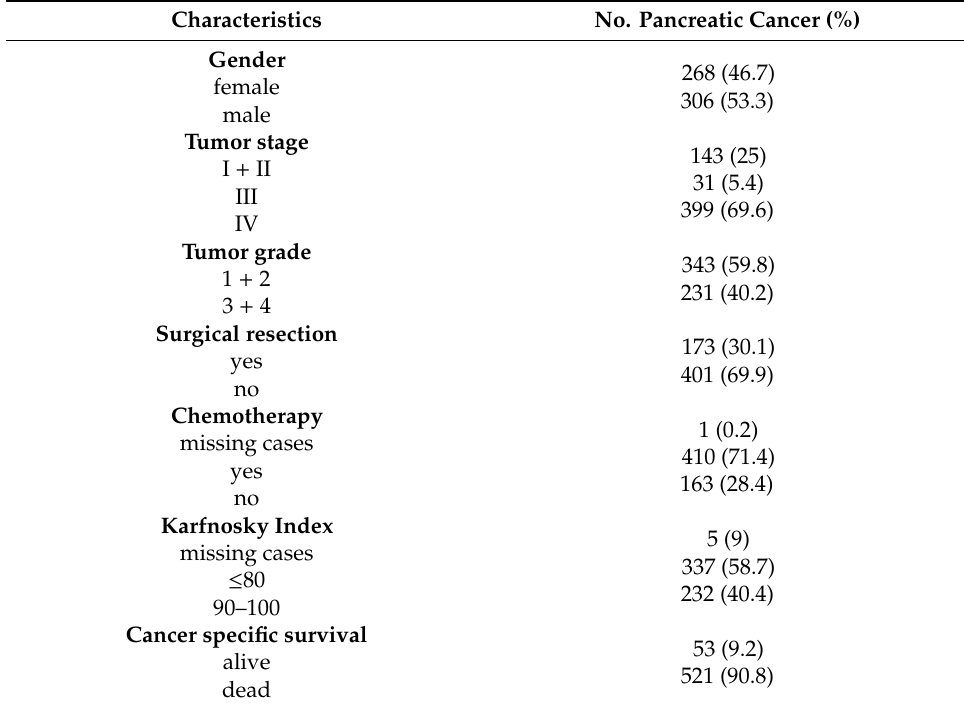
Table 1. Clinico-pathological characteristics of patients comprising the study cohort ( n =